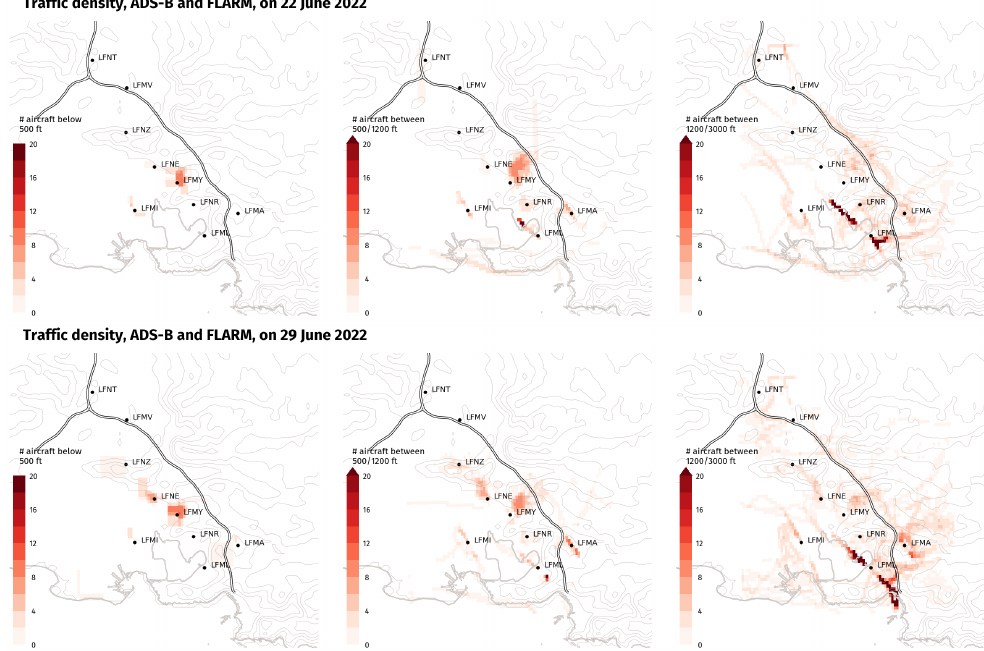
Figure 6. Density maps on various days (or various hours of days) reflect different levels of activity, even on the same day of the week (Wednesday). Activity above 1200ft may look similar on both days, but activity below 1200ft looks denser on 29 June